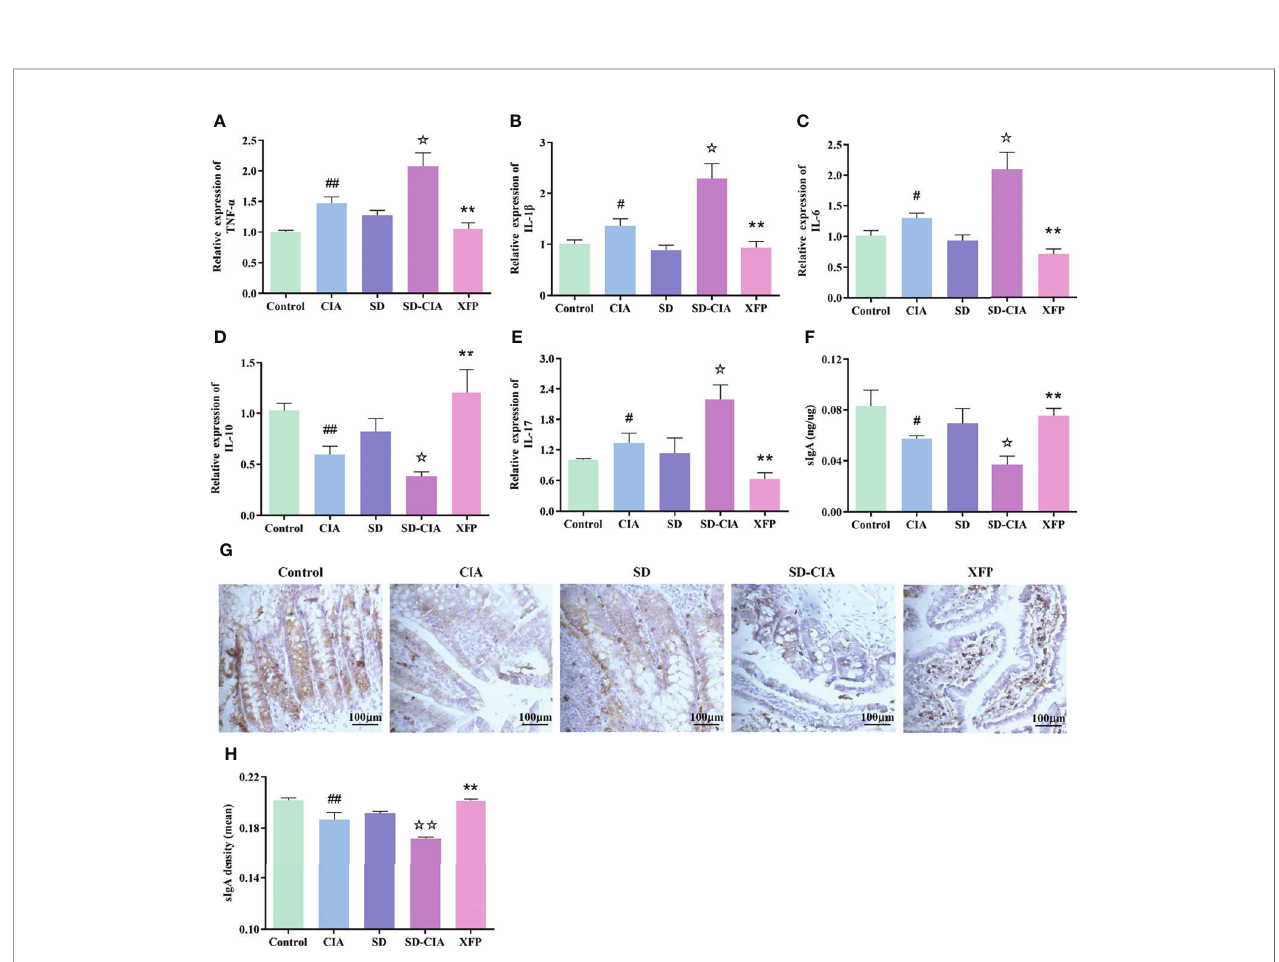
FIGURE 5 | The regulatory effect of XFP on immune status of jejunum and ileum. (A – E) RNA expression of TNF- a , IL-1 b , IL-6, IL-10 , and in the jejunum and ileum. (F) The relative concentration of sIgA in the jejunum and ileum as measured by ELISA. (G) Representative images of the expression of sIgA in the jejunum and ileum obtained by IHC. (H) Relative expression of sIgA in the jejunum and ileum via IHC. n = 8 . Data are presented as the mean ± SEM. # P < 0.05 and ## P < 0.01 compared to the control group; ☆ P < 0.05 and ☆☆ P < 0.01 compared to the CIA group; **P < 0.01 compared to the SD-CIA group. XFP, Xiong Fu powder; CIA, collagen-induced arthritis; SD, spleen de fi ciency; SD-CIA, collagen-induced arthritis with spleen de fi ciency; TNF, tumor necrosis factor; IL, interleukin; qRT-PCR, quantitative real-time polymerase chain reaction; sIgA, secretory immunoglobulin A; ELISA, enzyme-linked immunosorbent assay; IHC,